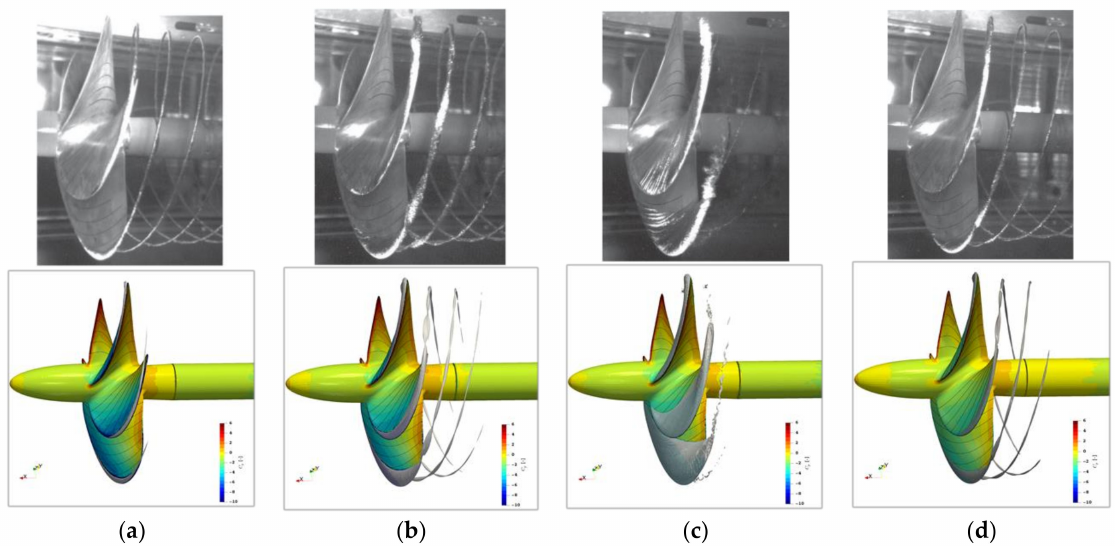
Figure 11. Newcastle. Comparison with experiment, reproduced from [15], with permission from Elsevier, year 2021: ( a ) C1; ( b ) C2; ( c ) C3; ( d ) C6.